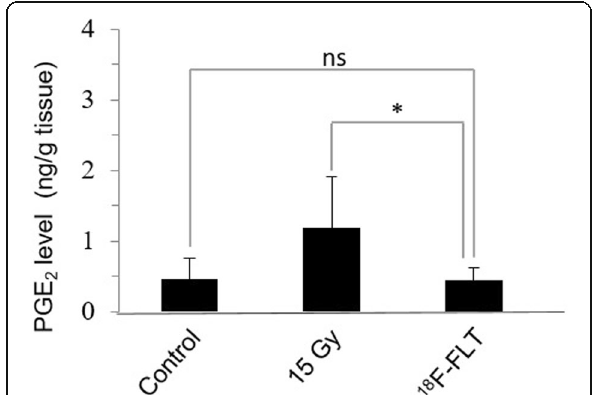
Fig. 7 LC/MS/MS quantification of PGE 2 in muscle tissues nearby irradiated tumors. Tumors received either 15 Gy gamma irradiation or i.t. injection of 5 MBq 18 F-FLT. The animals were euthanized 4 h post-treatment. ns: p > 0.05; * p ≤